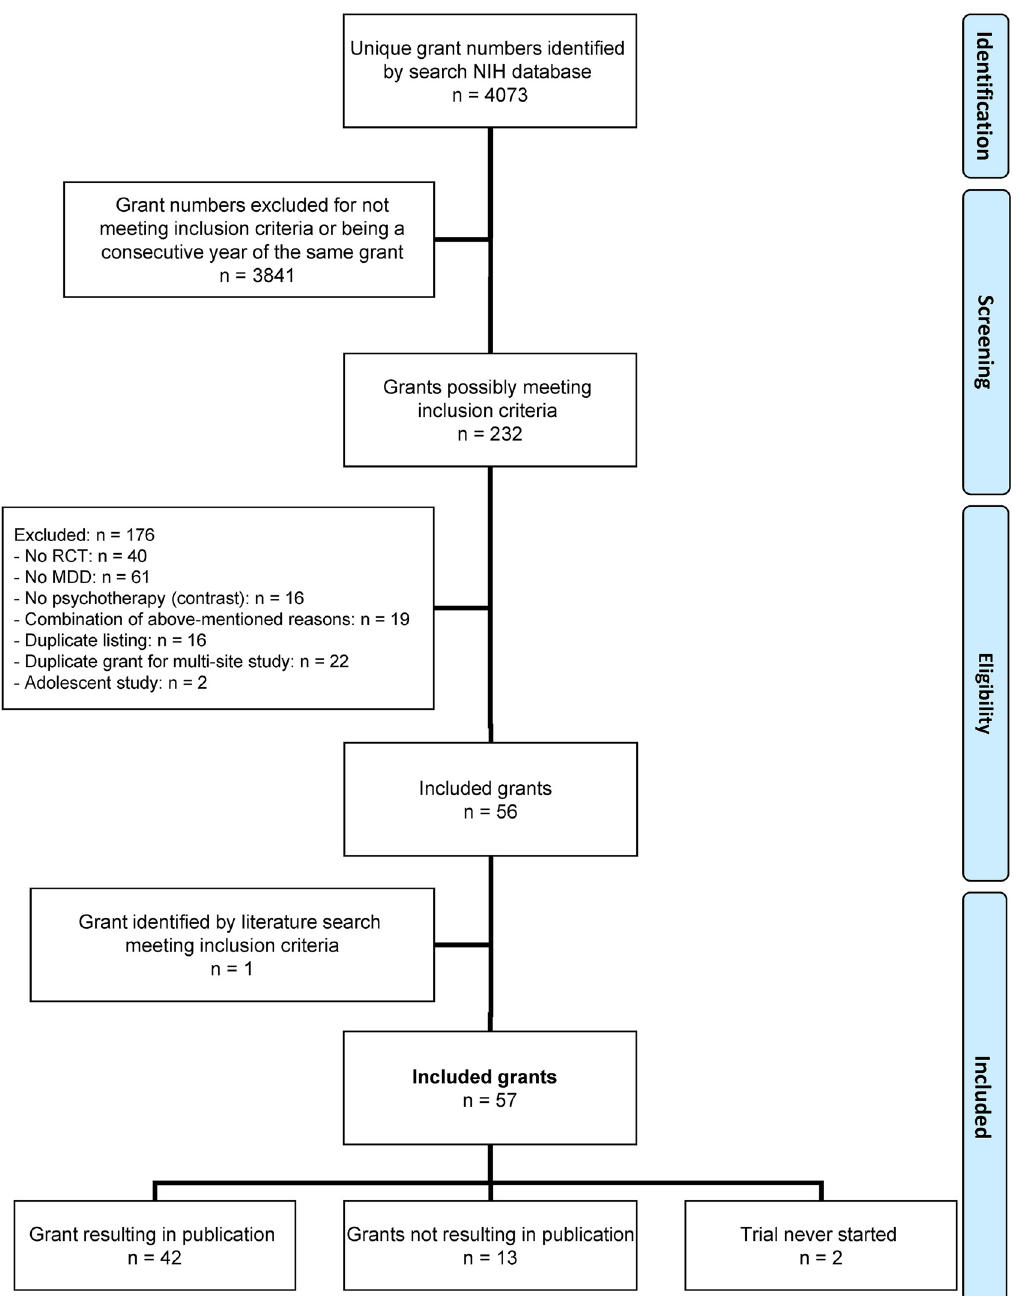
Fig 1. PRISMA flow chart of grants identified and the extent to which these led to publications. Note: MDD = major depressive disorder; NIH = US National Institutes of Health; RCT = randomized clinical trial.